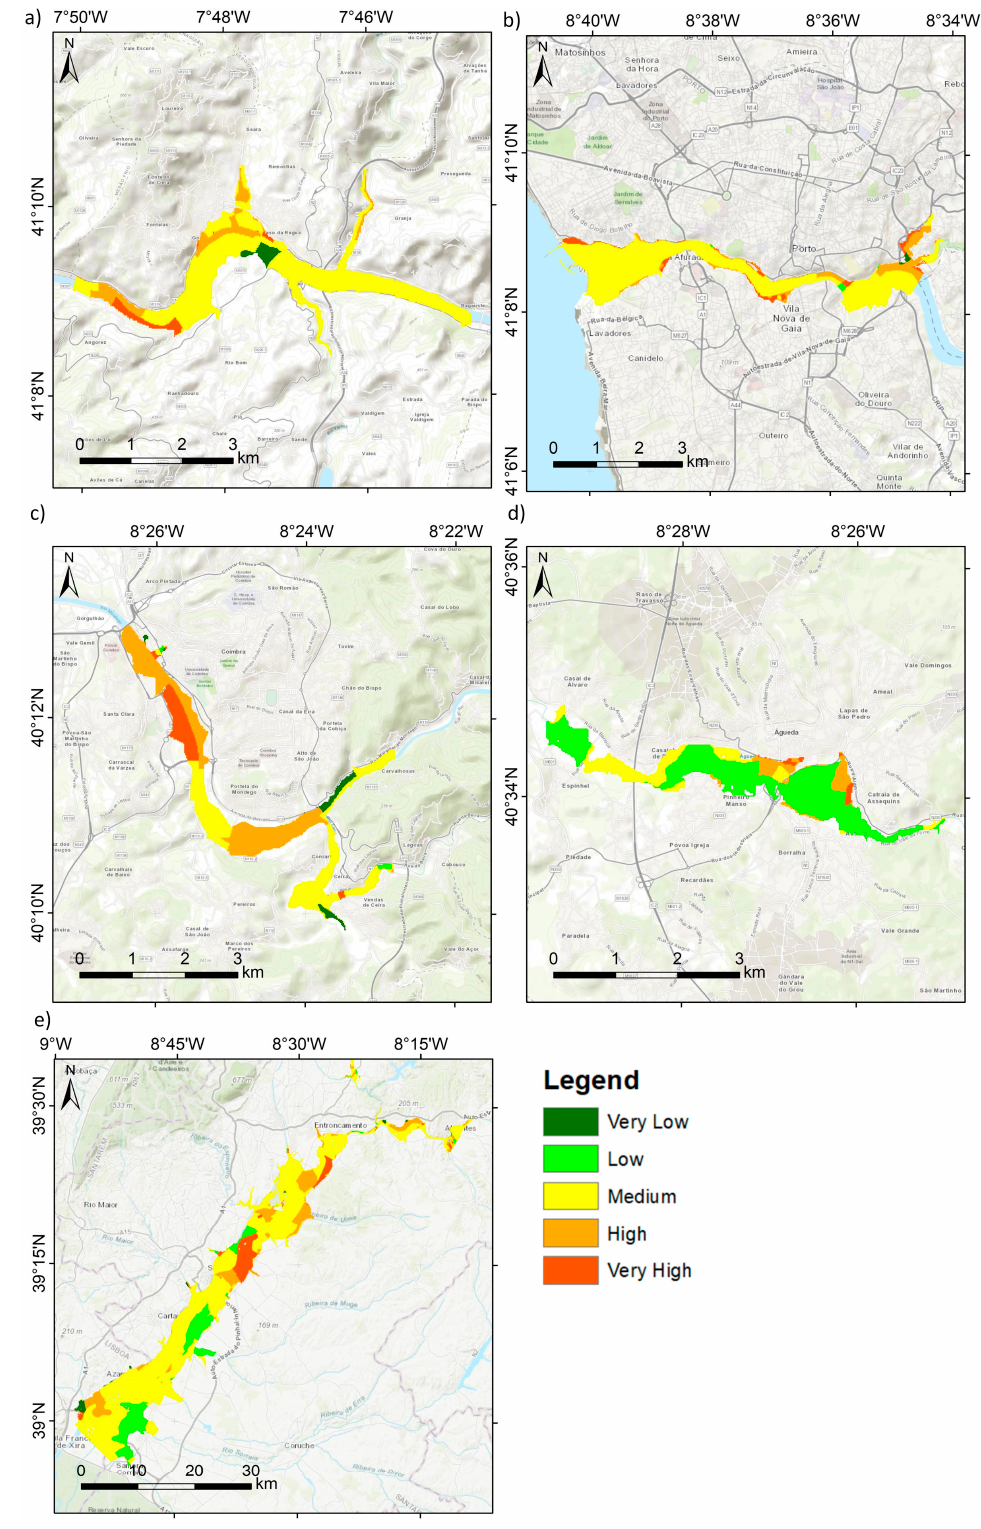
Figure 8. Flood vulnerability in five of the flood-prone areas: ( a ) R é gua (Douro River); ( b ) Porto/Vila Nova Gaia (Douro River); ( c ) Coimbra (Mondego River); ( d ) Á gueda ( Á gueda River); ( e ) Abrantes/Santar é m/Vila Franca Xira (Tagus